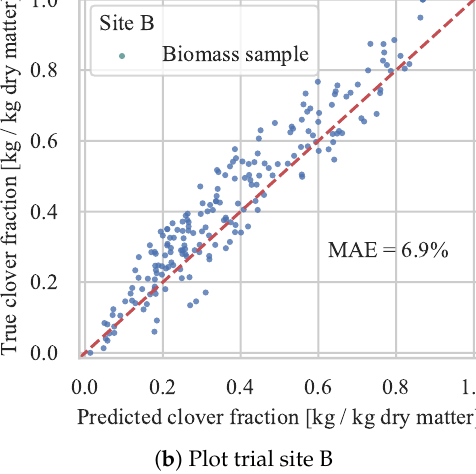
( b ) Plot trial site B